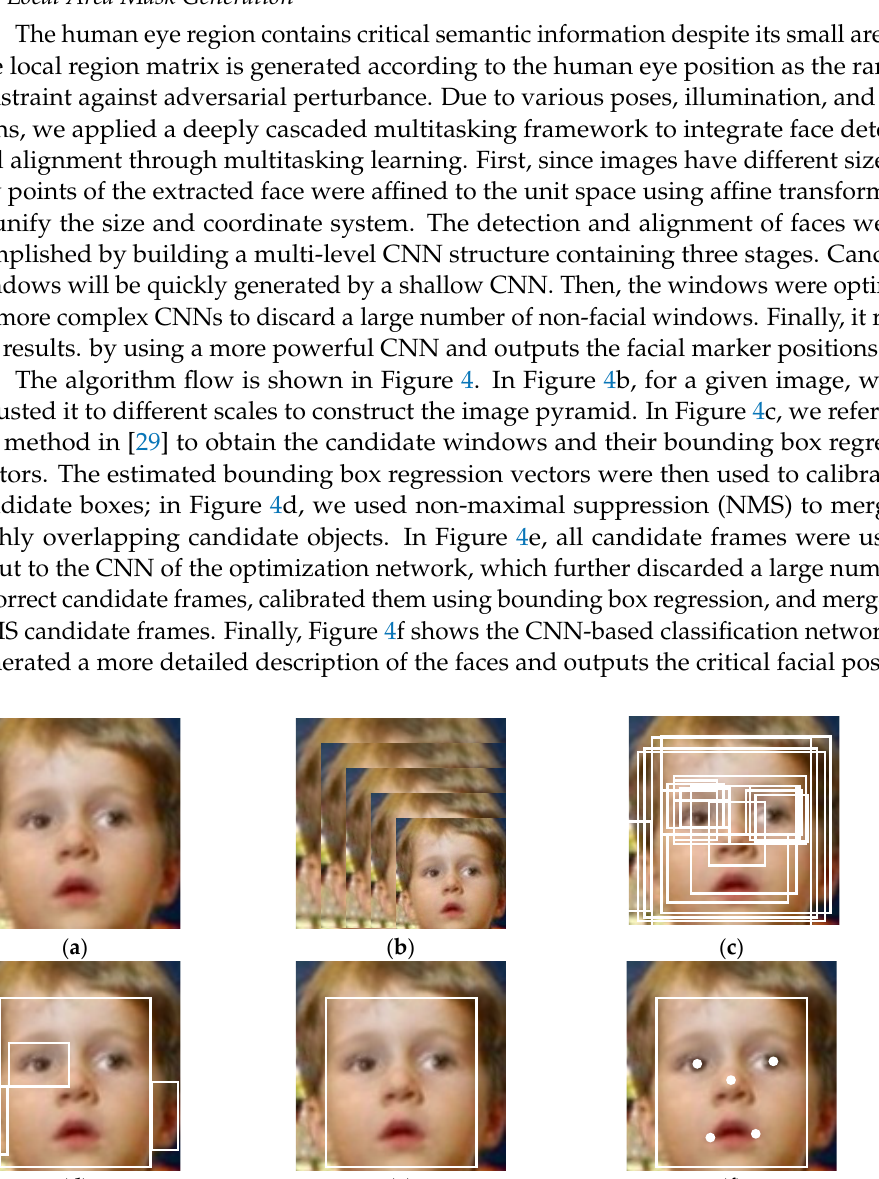
( c ) Figure 5. Schematic diagram of key point detection for human face. ( a ) Sixty-eight key points on a human face. ( b ) Face that needs to be matched. ( c ) Key points and face fitting. We located the human eye region based on the key points of the detected eye in the image and drew the mask against the attacked region. The range of pixel values in the generated mask image was normalized to [0.0, 1.0] to generate a binary-valued mask ma- trix. This is shown in Figure 6.